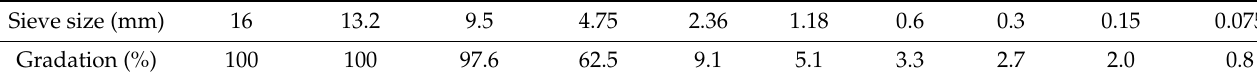
Table 3. Sieve size gradation.